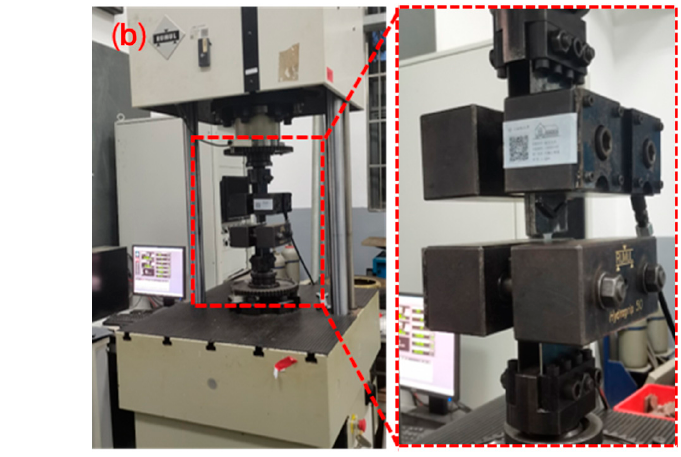
Figure 21. Fatigue specimen test diagram.